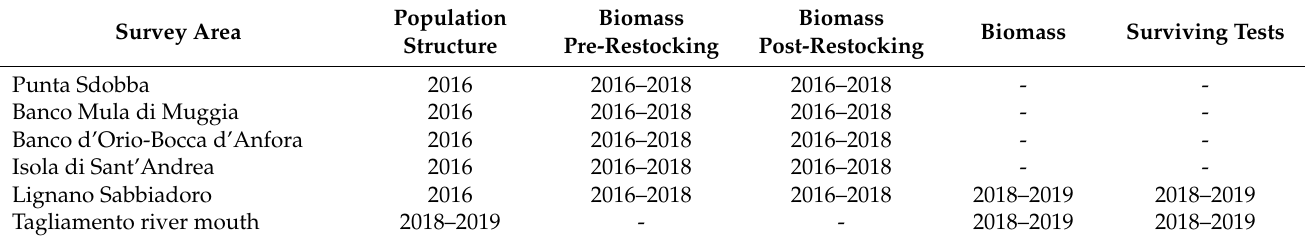
Table 4. Investigated coastal strip of Friuli-Venezia Giulia (northeast Italy) by year for Chamelea gallina . The data are contained in the scientific reports AGRI.TE.CO. produced for the Friuli-Venezia Giulia Region and the Co.Ge.Mo. of Monfalcone